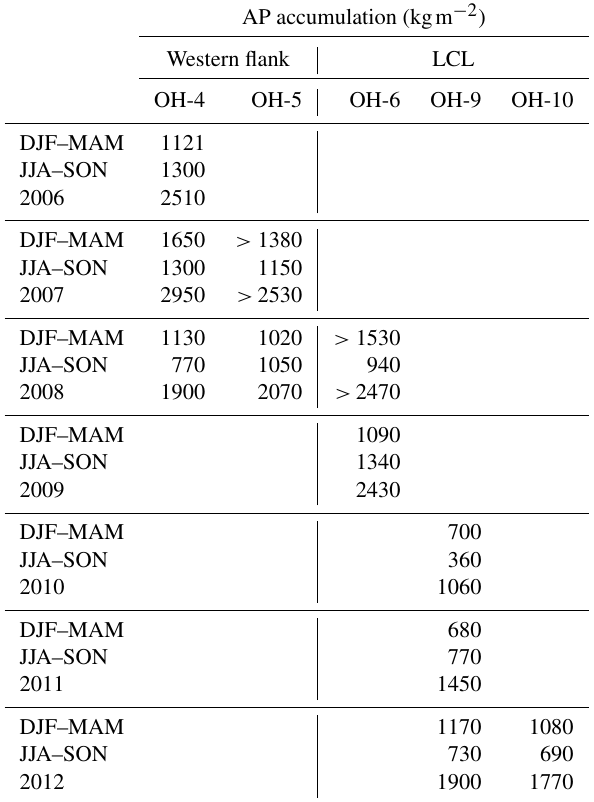
Table 5. Accumulation rates calculated for all firn cores used in this study. All rates are shown as seasonal and annual mean values with respect to the time interval covered by each